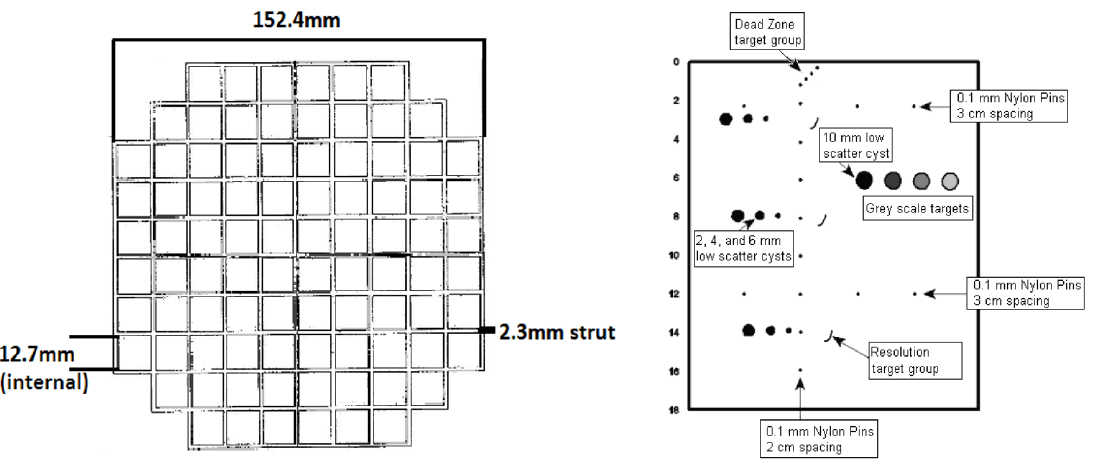
Figure 1. Manufacturer specifications of ACR phantom ( left ) and ultrasound phantom ( right ); images courtesy of JM Speciality Parts and Sun Nuclear.